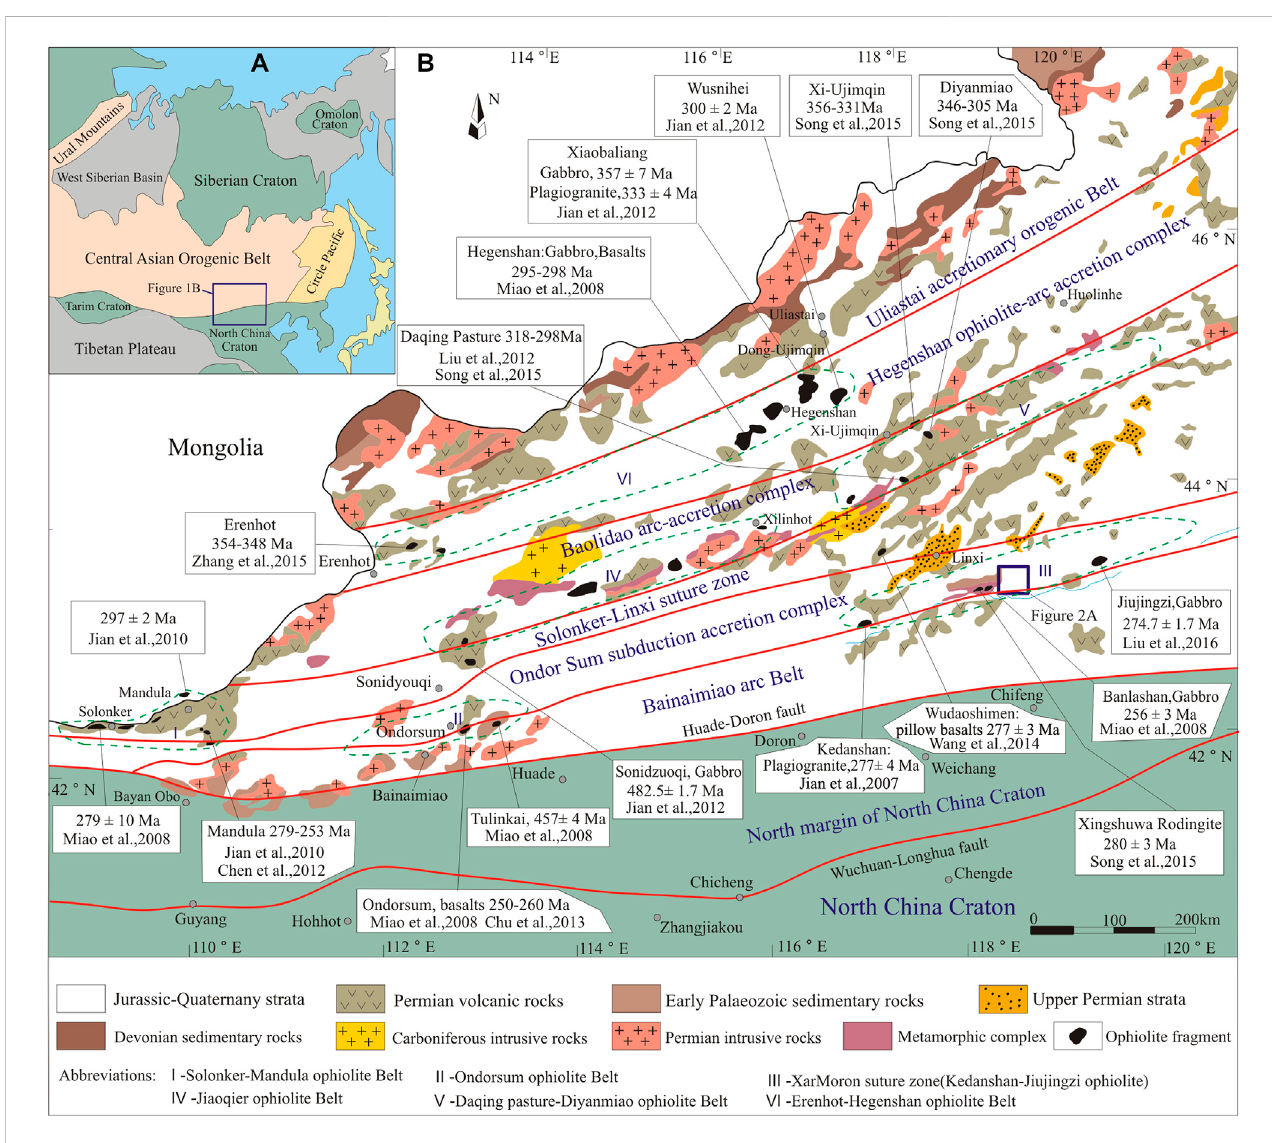
FIGURE 1 (A) Schematic diagram showing the main tectonic subdivisions of Central and Eastern Asia (Song et al., 2015). (B) Geological map of central Inner Mongolia of the CAOB showing tectonic units (Xiao et al., 2003; Song et al., 2015; Li et al.,